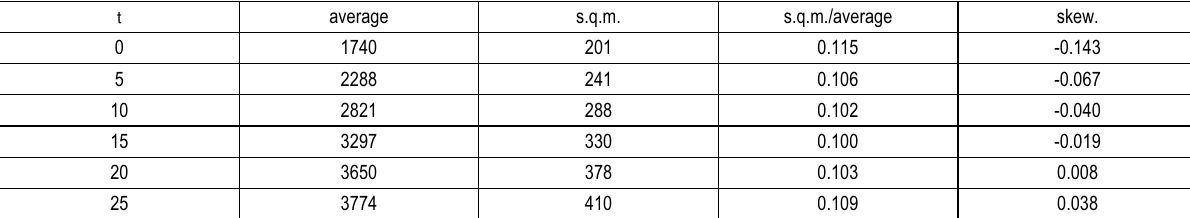
(cid:5) U evidenced for the standard stochasticity level, with contract escapes t